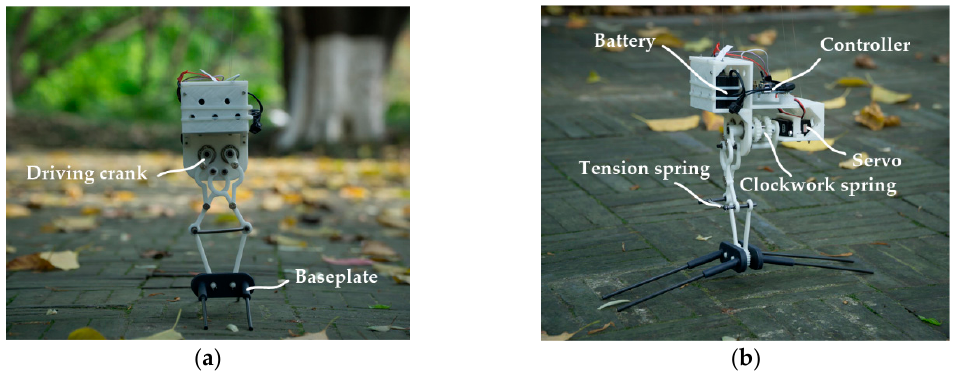
Figure 12. Robotic prototype. ( a ) Front view. ( b ) Side view.